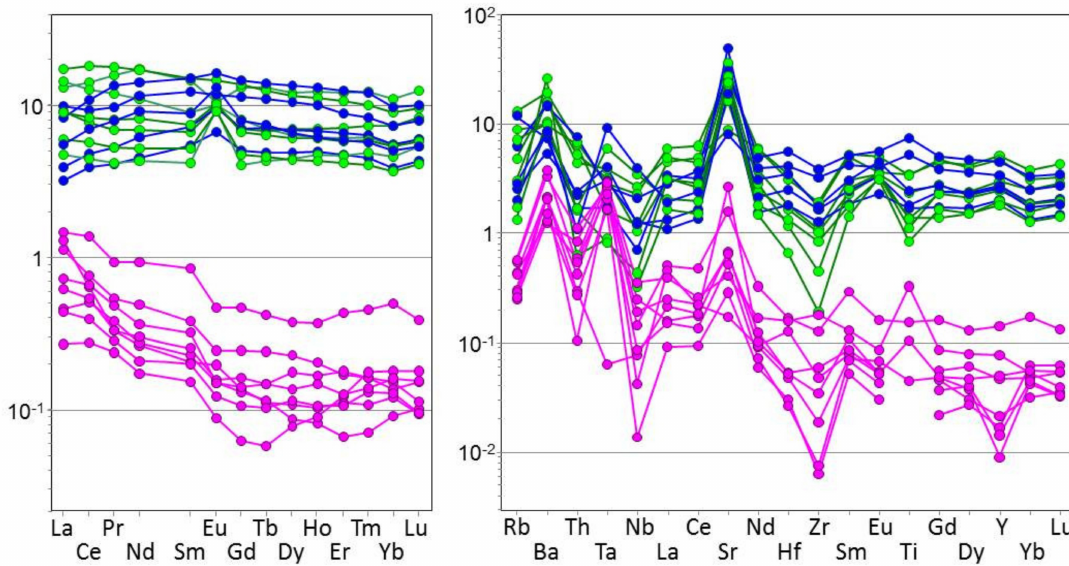
Figure 13. Chondrite-normalized rare earth element and primitive mantle-normalized trace element spectra in ophiolitic gabbros and peridotites. Color legend is the same as in Figure 12. Chondrite and primitive mantle compositions are after